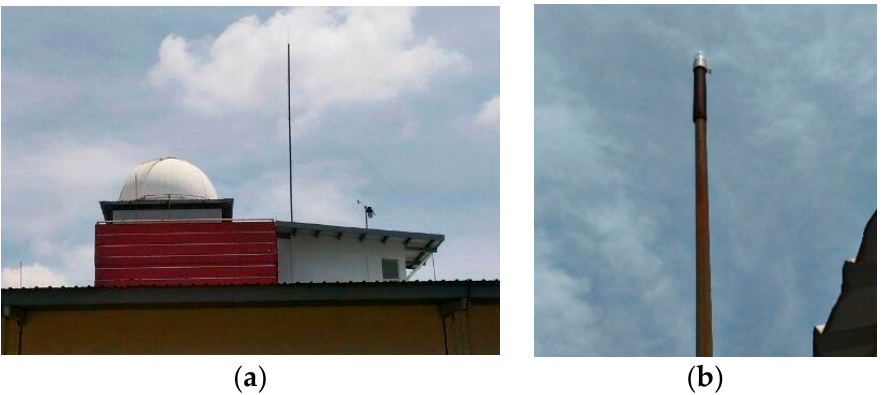
Figure 1. ( a ) An image of the PERMATApintar Observatory and ( b ) an enlarged image of the all- sky imager next to the observatory. Table 1. The specifications of the all-sky imager [21].